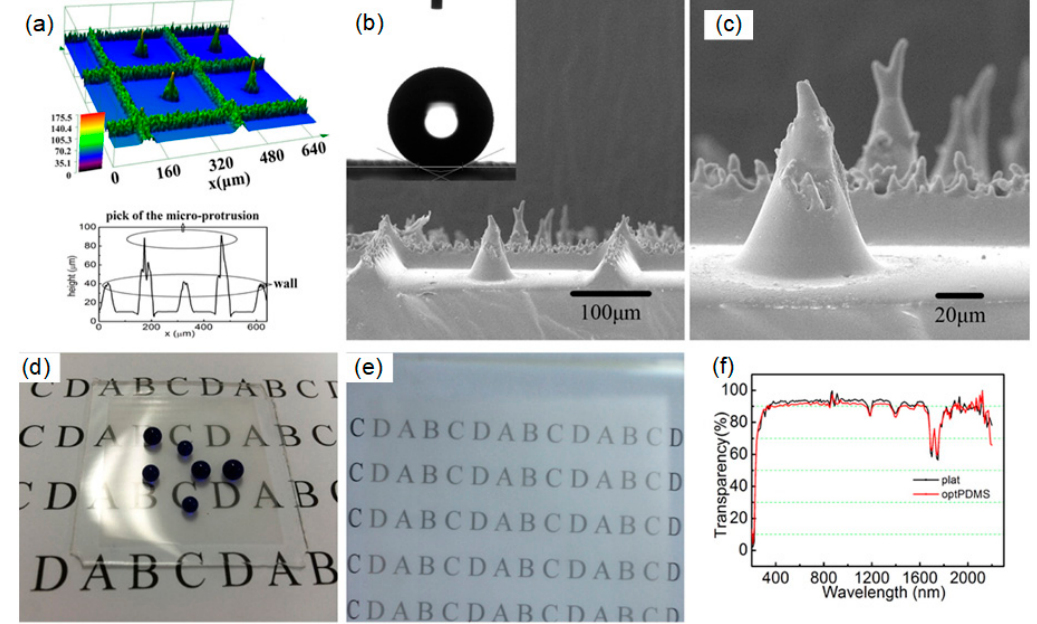
Figure 9. Surface microstructure of PDMS as result of molding into a stainless steel substrate: ( a ) microscopic data and SEM images under ( b ) 500× and ( c ) 2000× magnification. The SCA of the thin optimal surface is 154.5° ± 1.7° and SA° ± 0.5°. Optimally-designed PDMS ( d ) coated on paper and ( e ) placed at 10 cm from the paper. ( f ) Transparency of the optimally-designed surface is over 91% in the visible light wavelength. Reproduced from [102] with permission; Copyright ACS 2016.